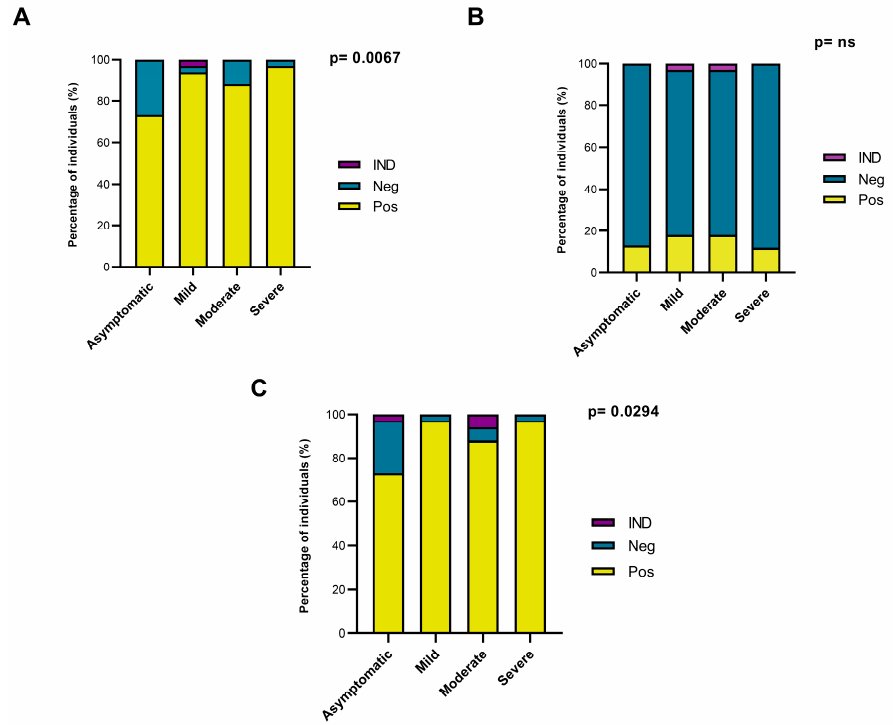
Figure 1. Analysis of the total IgG response to SARS-CoV-2 S and N proteins in individuals with different clinical profiles of COVID-19. ( A ) Analysis of the total IgG response to the S1 subunit of S. ( B ) Analysis of the total IgG response to the S2 subunit of S. ( C ) Analysis of the total IgG response to N. Pos: Positive ELISA result. Neg: Negative ELISA result. IND: Indeterminate ELISA result. ns: